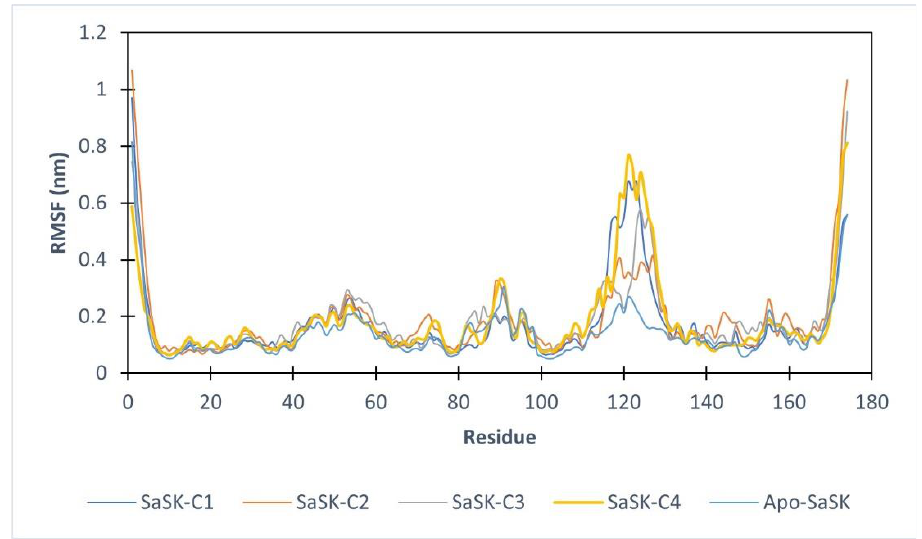
Figure 4. Root mean square fluctuation analysis for free enzyme and the different protein–ligand complexes.